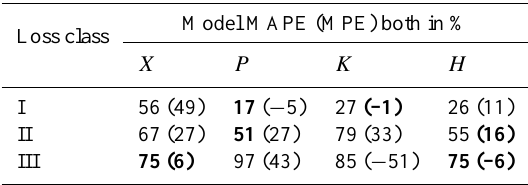
Table 4. Estimates of the mean absolute percentage error (MAPE) and mean percentage error (MPE) for each of the competing models and across loss classes (as defined in Table 1) based on DWD wind gust data. Best values for each class are emphasized in bold.